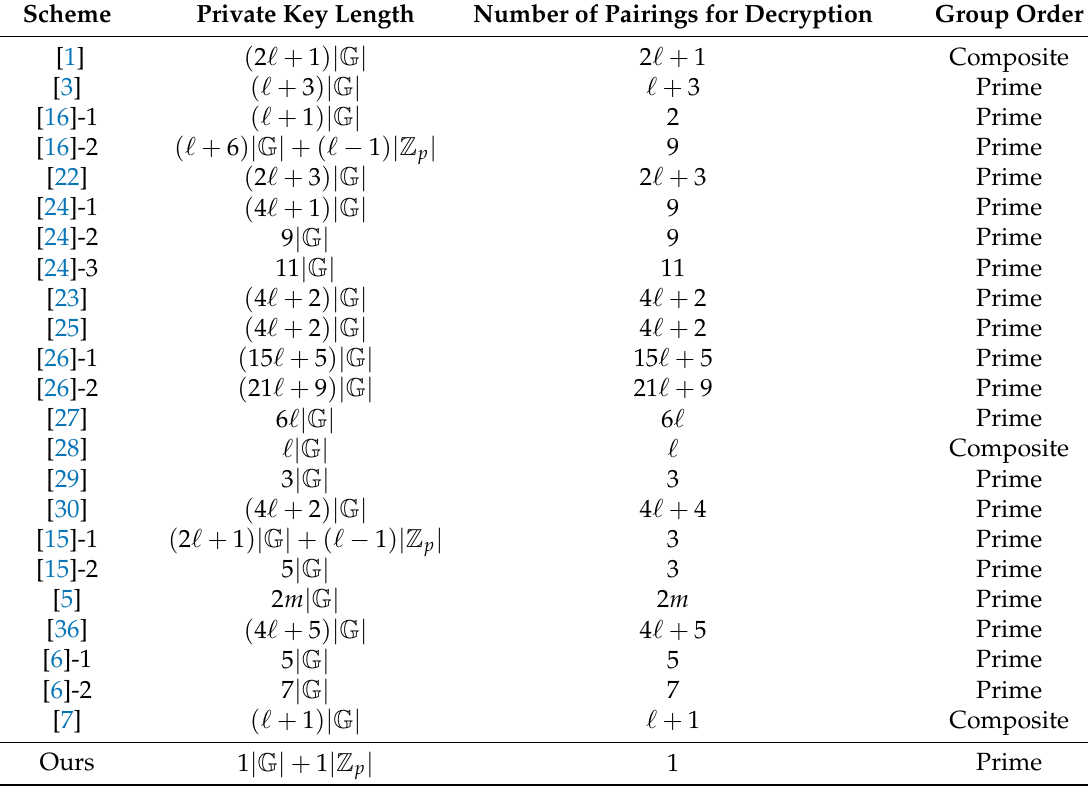
Table 1. Comparison of our scheme’s efficiency with that of other schemes. The vector length for an IPE scheme is denoted by (cid:96) ; the bit lengths of the representations for an element in Z p and G are denoted by | Z p | and | G | , respectively; the leakage resilience parameter is denoted by m .